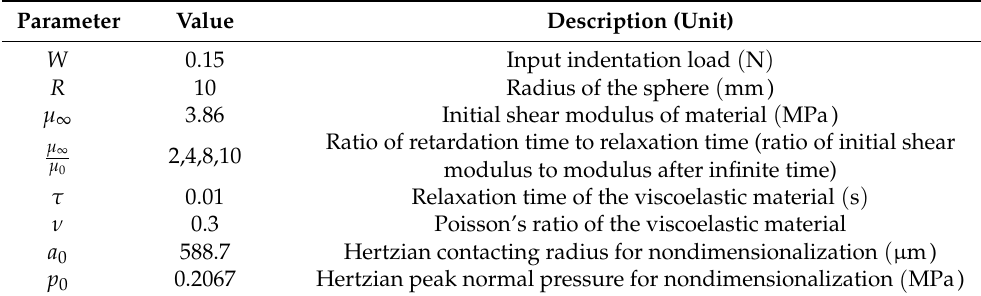
Table 2. Parameters used in the contact simulation of a rigid sphere indenting a viscoelastic half-space (Zener model) under constant normal